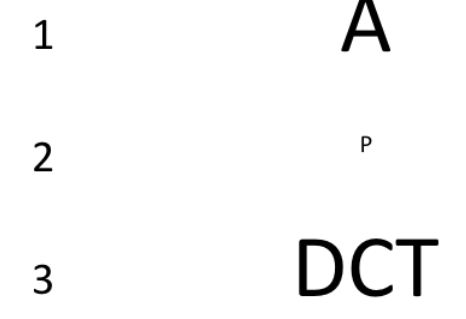
Figure 3. Acuity and crowding limit the UFOV.